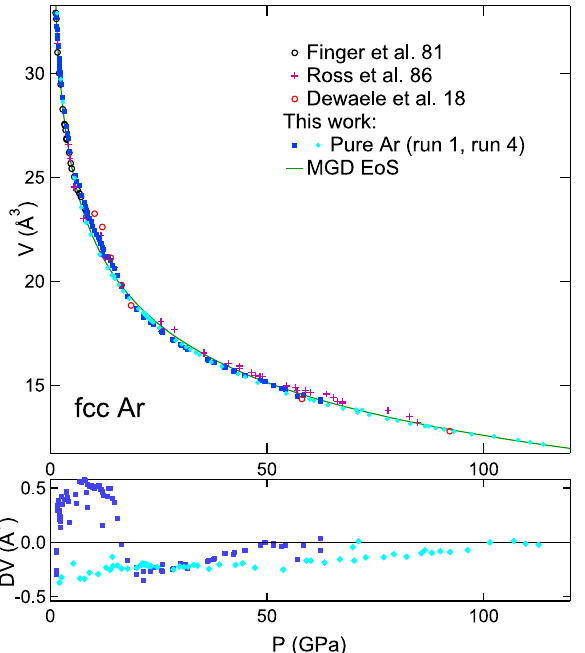
Figure 9. Equation of state of fcc-Ar directly compressed between diamond anvils. Top graph: atomic volume vs pressure measured with Au standard 28 . Current and literature 2,3,6 experimental P – V points have been plotted, with an updated pressure metrology for Refs. 2,3 . Bottom graph: difference between measured volume and volume calculated using quasi-hydrostatic Mie–Grüneisen–Debye (MGD) EoS described in the text and Table